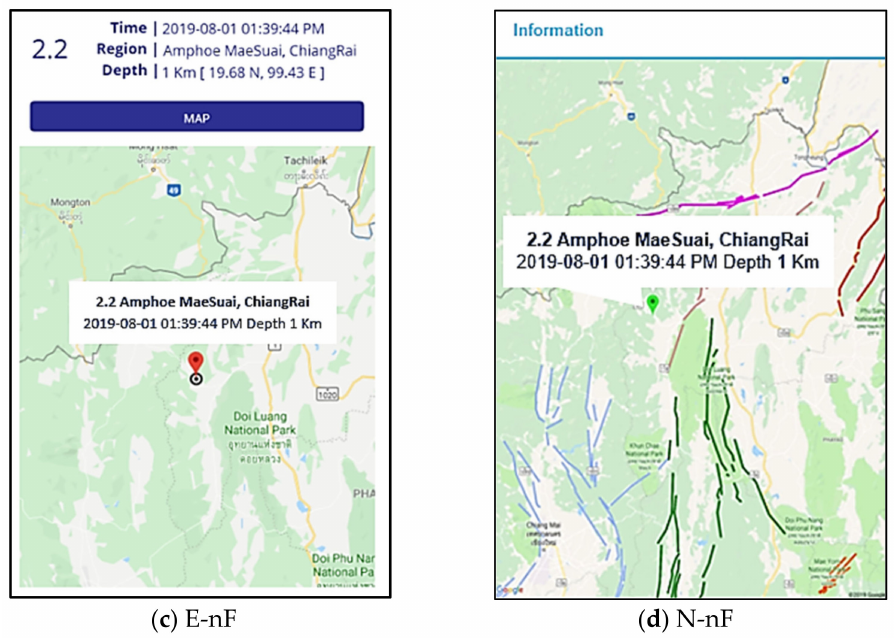
Figure 7. The redesigned user interfaces: ( a ) N-F by designer 1; ( b ) E-F by designer 2; ( c ) E-nF by